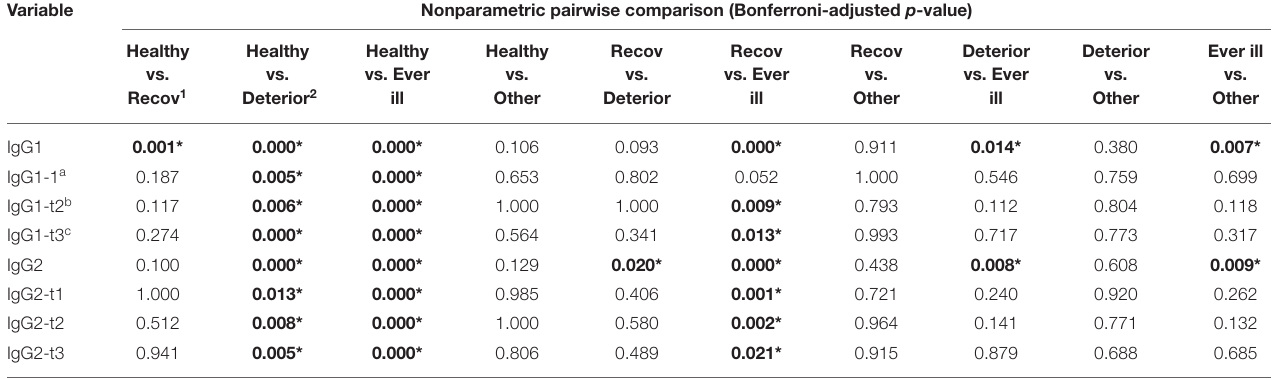
TABLE 9 | Pairwise comparison of mean absorbance readings across different BDD health categories. Variable Nonparametric pairwise comparison (Bonferroni-adjusted p -value) Healthy vs.